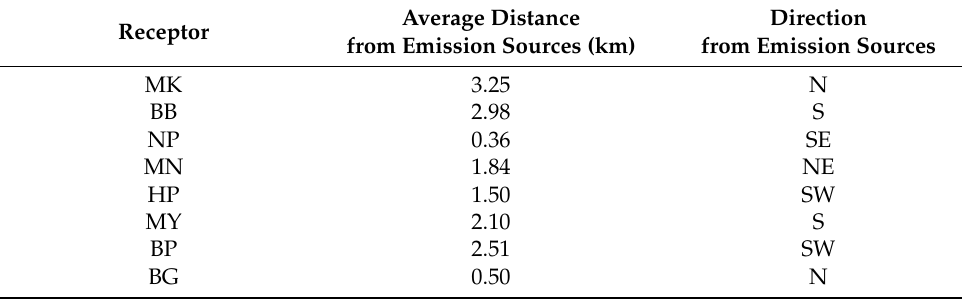
Table 5. Information for the receptors in the modeling domain.